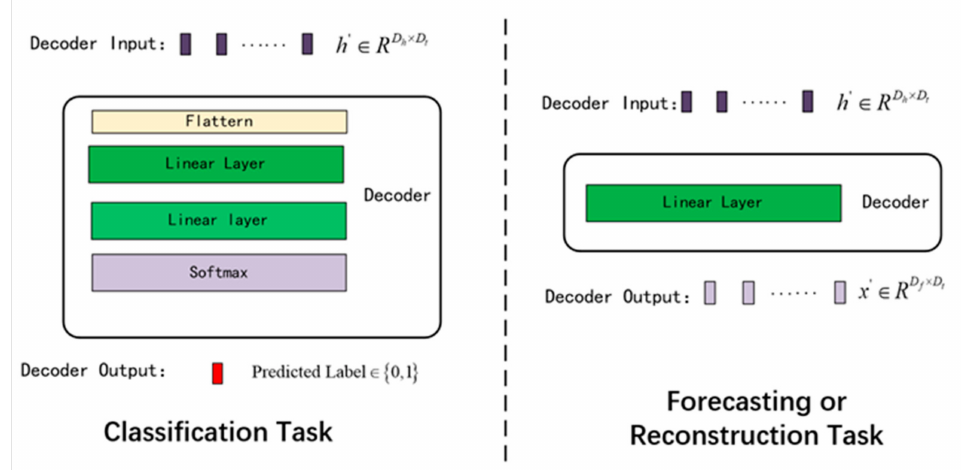
Figure 4. Decoders of different tasks. The inner structure of the decoder is sequential.